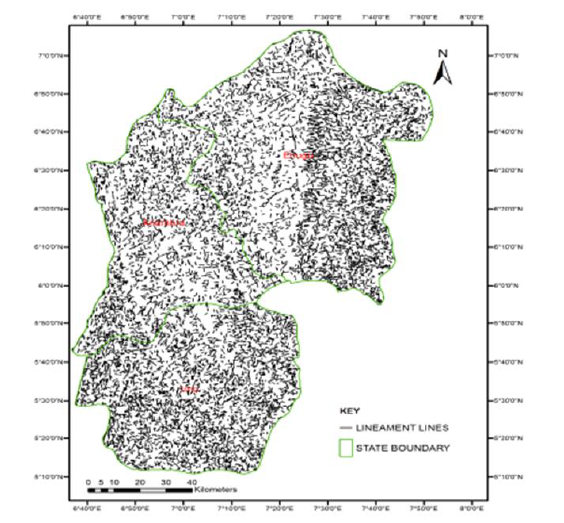
Figure 6: Lineament Buffer Map of the Study